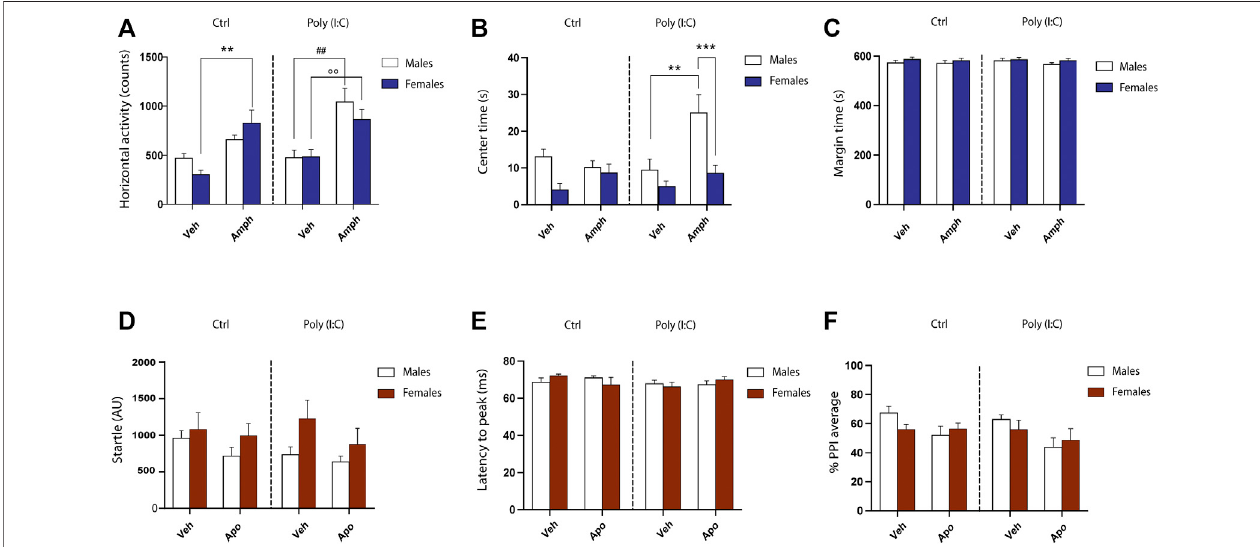
FIGURE3| BehavioralphenotypesinF2maleandfemalepoly(I:C)rats. (A) Countsofhorizontalactivityperformedintheopen fi eld. (B) Time(seconds)spentinthe center of the open fi eld. (C) time spent in the periphery of the open fi eld. Transgenerational effects of poly (I:C) on mean startle amplitude (D) , latency to peak (E) and prepulse inhibition (PPI) (F) . AU, arbitrary unit; ms, milliseconds. For further details, see the text. Data are expressed as means ± SEM. * p < .05 vs. rats treated with vehicle